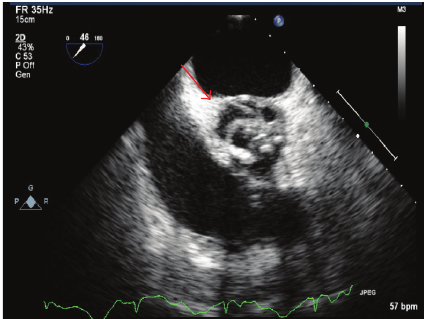
Figure 2: Transesophageal echocardiogram at midesophageal inflow/outflow tract revealing subannular abscess, in diastole.